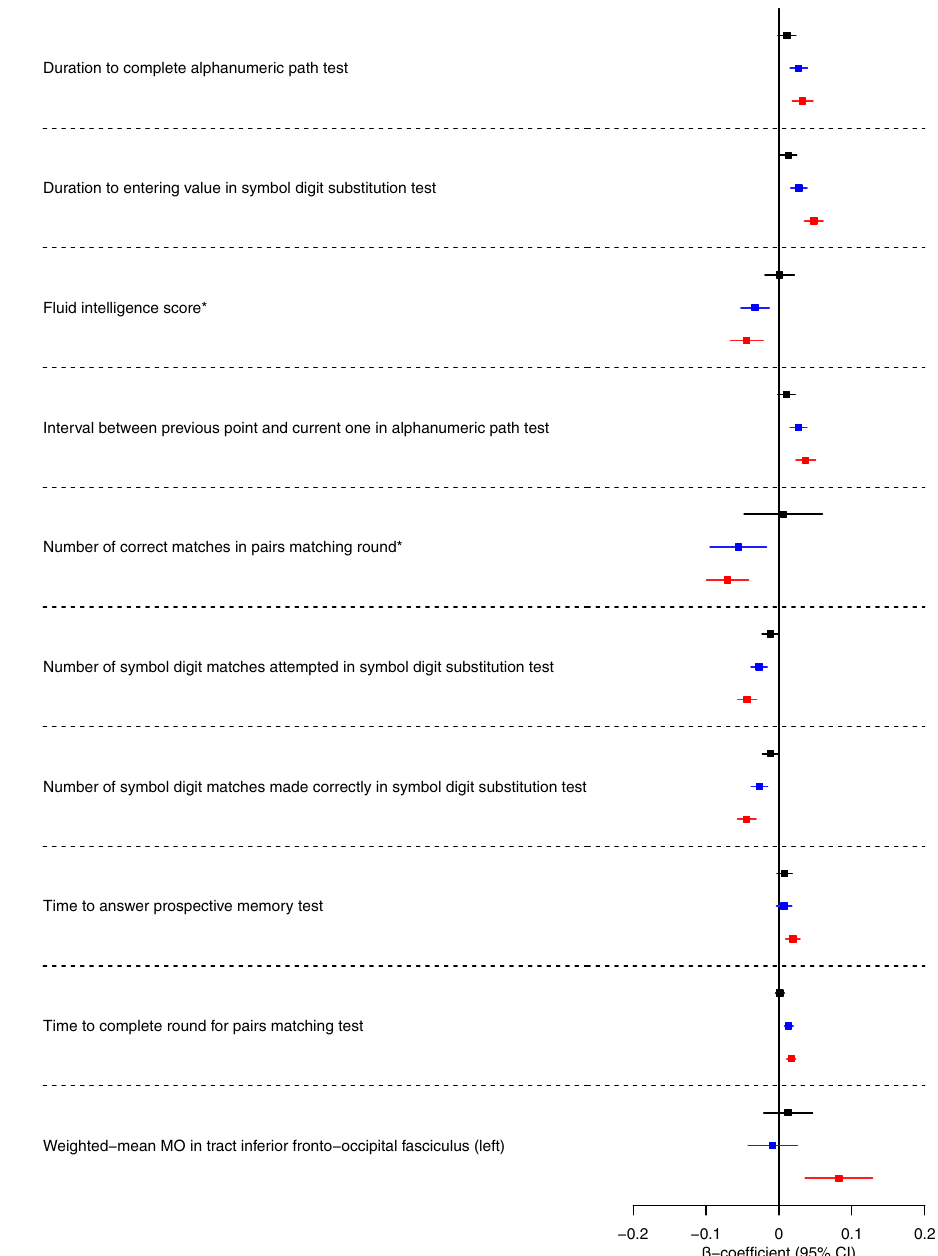
Fig.3|Forestplotshowingtheeffectestimatesfortheassociationbetweenthe polygenicscore for Alzheimer ’ sdisease(including the APOE region),cognitive and brain-related measures. Legends at the bottom of each graph indicate age tertiles. Each tertile consists of 111,656 participants, ordered by age. Effect esti- mates represent an SD change in the phenotype per 1 unit increase in the stan- dardized polygenic risk score for Alzheimer ’ s disease. Error bars represent 95%